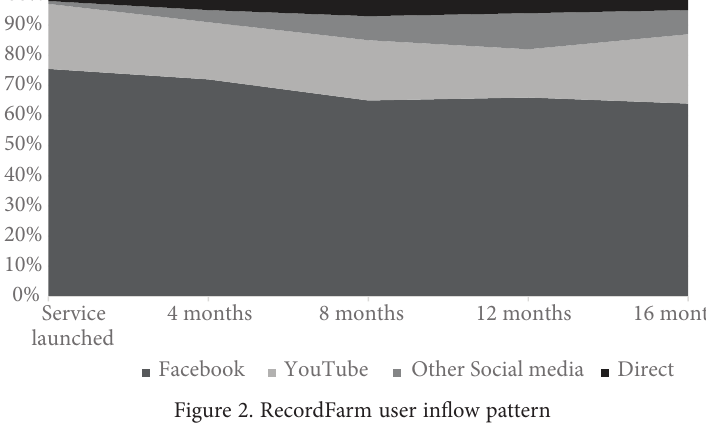
Figure 2. RecordFarm user inflow